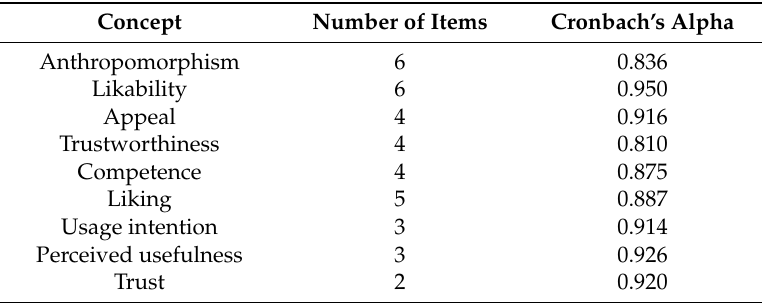
Table 6. Dependent variables’ reliability